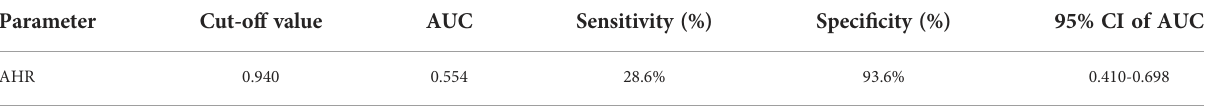
TABLE 2 \Cut-off value and AUC of the AHR after surgical resection.